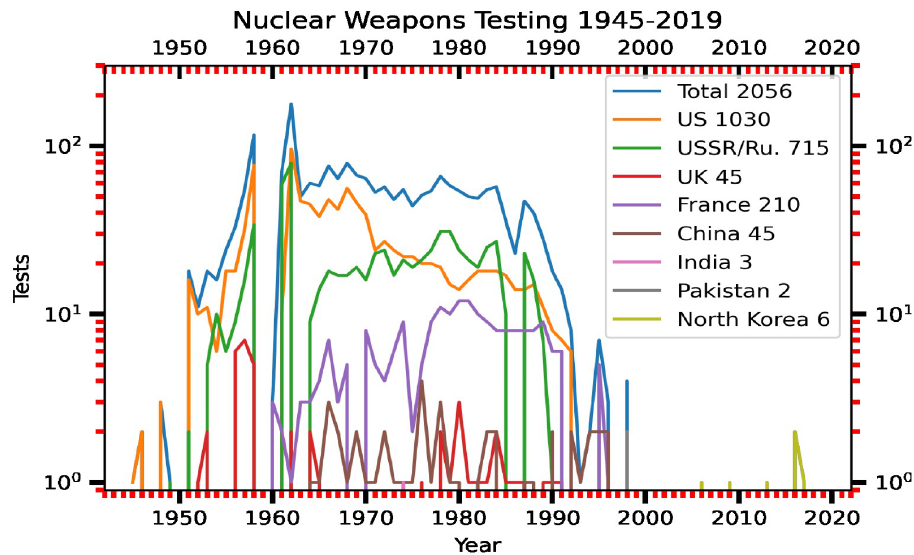
For comparisons, the 20-kiloton TNT equivalent scale of nuclear explosion on 6 August 1945 at Hiroshima, and on 9 August 1945 at Nagasaki [106]. The air dose rates measured at the epi- center of the G1 explosion site is 35 μ Sv/h in 1962, and 0.1 μ Sv/h in 2015 [66]. The air dose rates measured at the epicenter of the G2 explosion sites is 160 μ Sv/h in 1962, and 0.2 μ Sv/h in